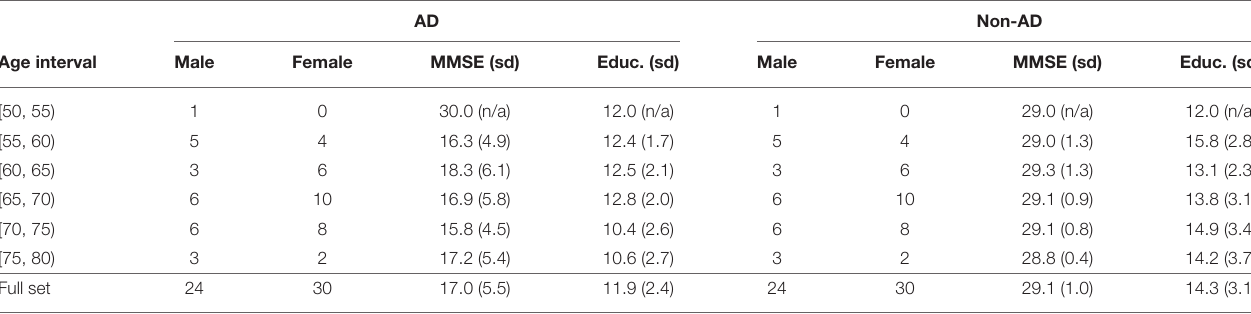
TABLE 2 | Age and gender details for patients in the test set, as well as the average MMSE scores, average years of education, and corresponding standard deviations (sd), for the patients in each age interval. AD Non-AD Age